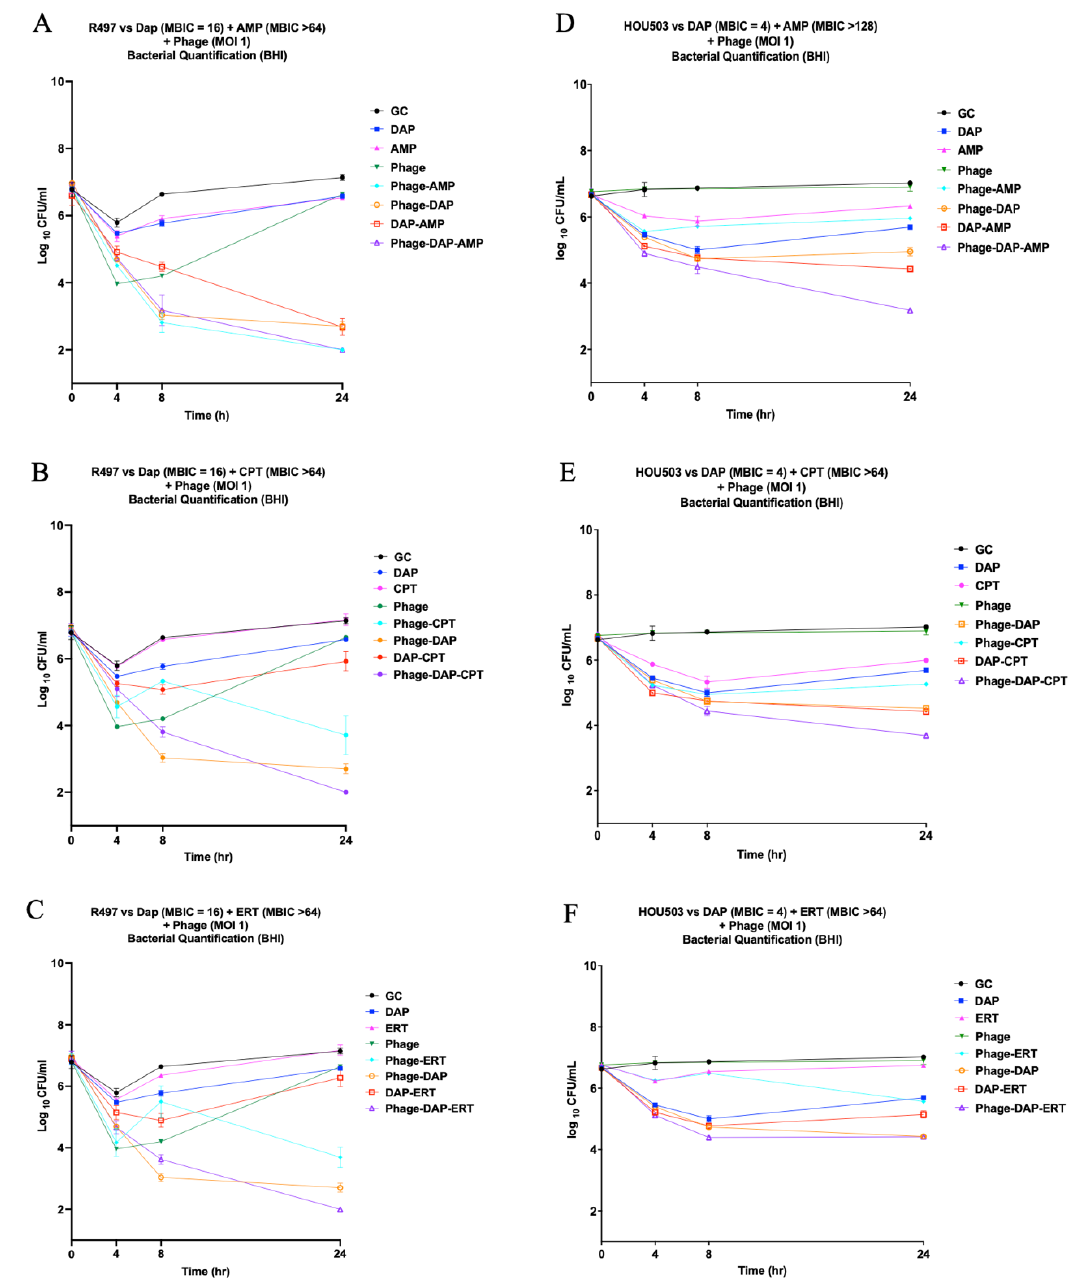
Figure 3. ( A – F ) Time-kill analysis of DAP-resistant and DAP-SDD E. faecium strains R497 and HOU503, respectively. GC, growth control. ( A ) R497 vs. DAP (0.5xMIC) + AMP (free peak concen- tration = 72) + phage (MOI = 1). ( B ) R497 vs. DAP (0.5xMIC) + CPT (free peak concentration = 13.2) + phage (MOI = 1) ( C ) R497 vs. DAP (0.5xMIC) + ERT (free peak concentration = 15.5) + phage (MOI = 1) ( D ) HOU503 vs. DAP (0.5xMIC) + AMP (free peak concentration = 72) + phage (MOI = 1) ( E ) HOU503 vs. DAP (0.5xMIC) + CPT (free peak concentration = 13.2) + phage (MOI = 1) ( F ) R497 vs. DAP (0.5xMIC) + ERT (free peak concentration = 15.5) + phage (MOI = 1). DAP, daptomycin; AMP, ampicillin; CPT, ceftaroline; ERT, ertapenem.